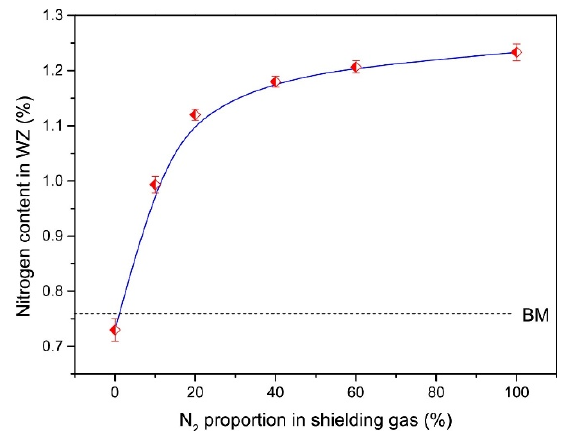
Figure 7. Effect of the N 2 content in the shielding gas on the nitrogen content of the weld. Reprinted with permission from ref. [12]. Copyright 2021,